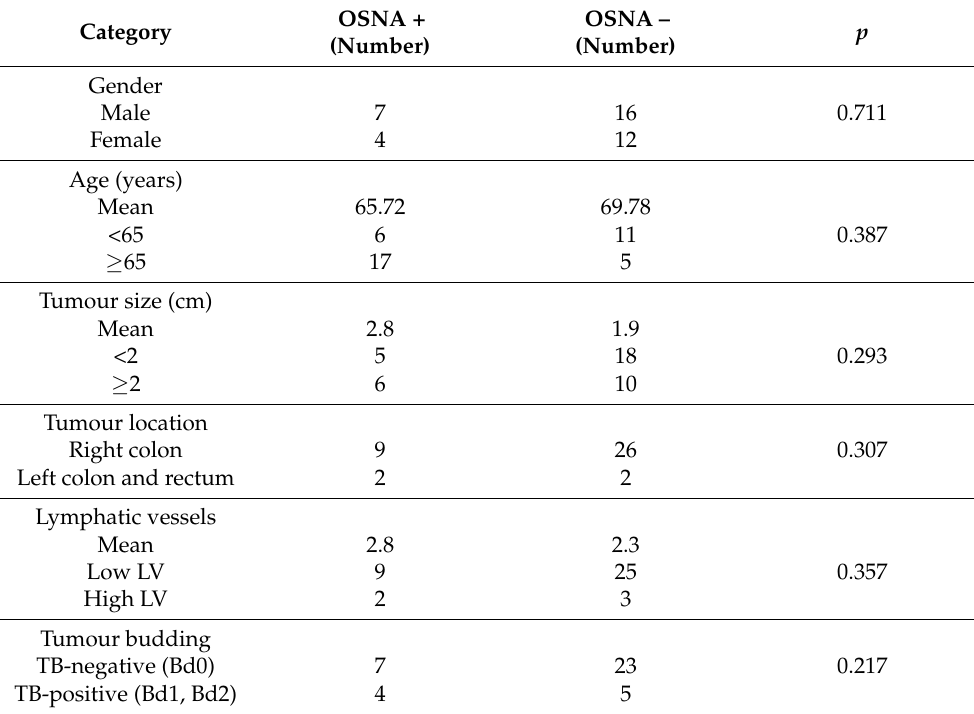
Table 3. Characteristics of pTis colorectal carcinomas according to OSNA